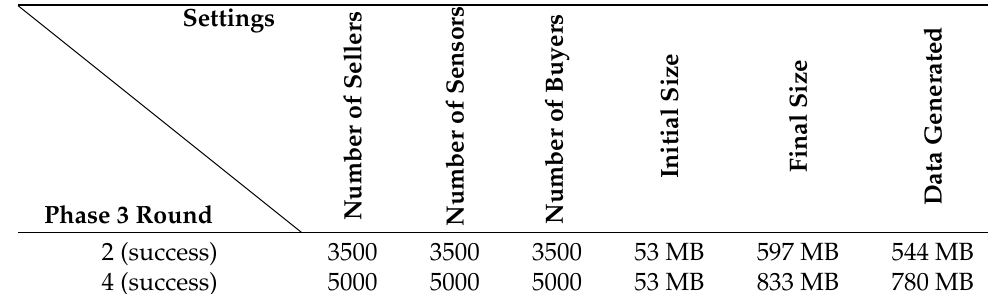
Table 6. Peer data generation in Phase 3.